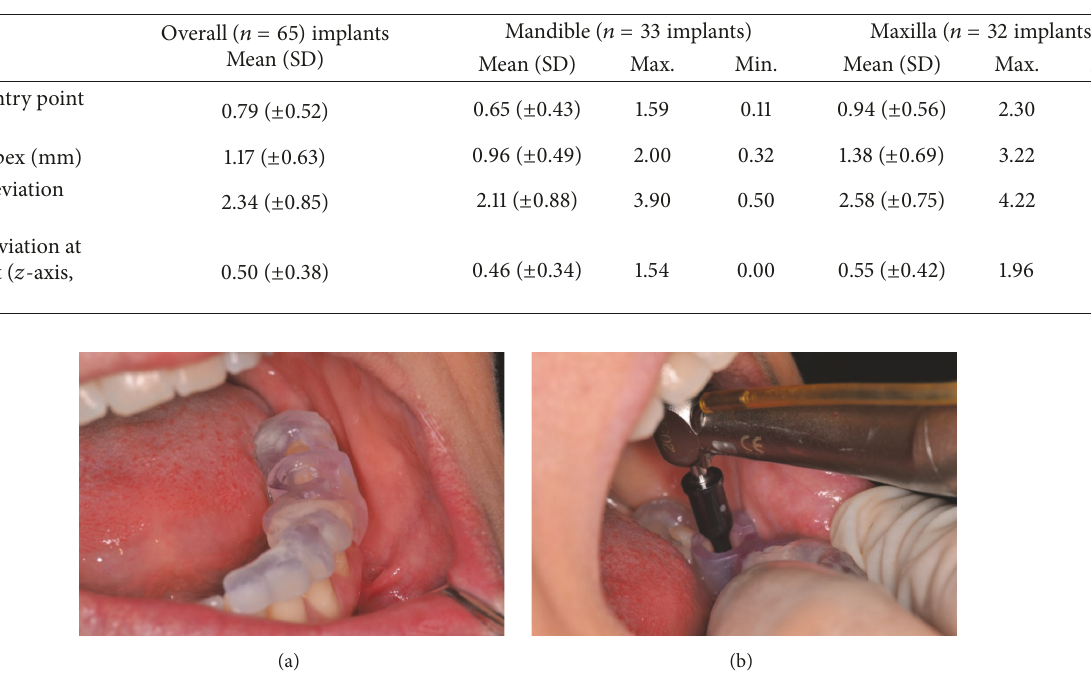
Figure 3: (a) Surgical template applied over the edentulous area and adjacent teeth. (b) Second drill used for flapless implant site preparation.